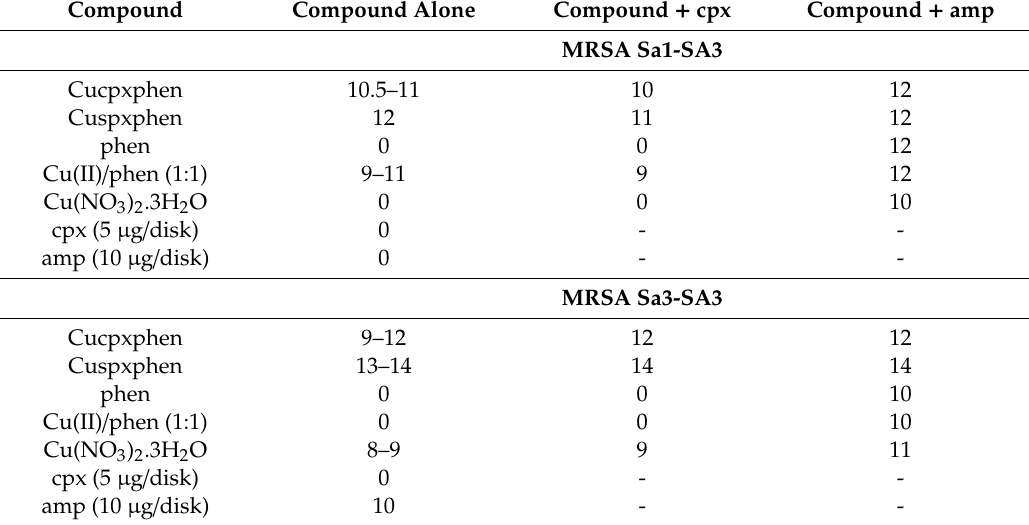
Table 4. Growth inhibition zones caused by Cucpxphen, Cuspxphen, phen, Cu(II) / phen (1:1),